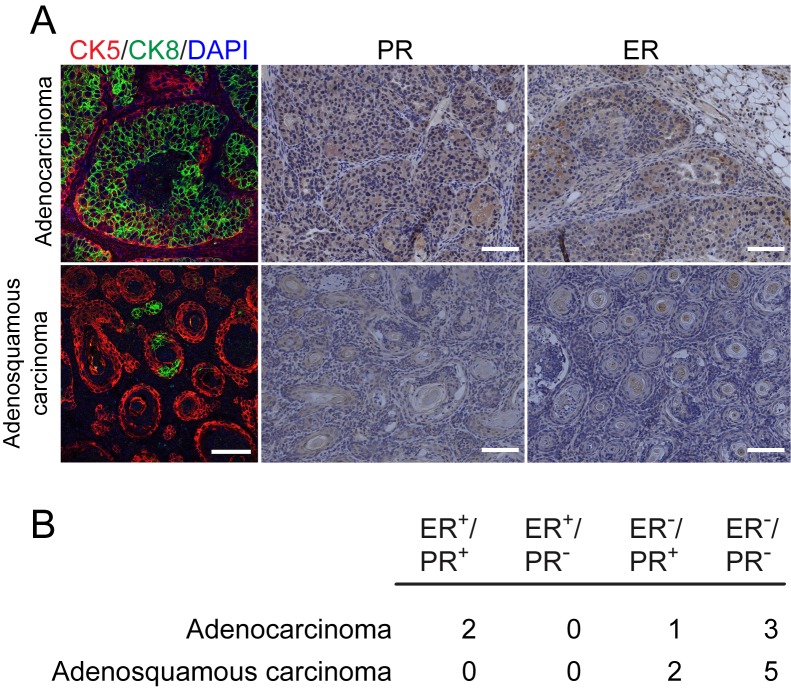
Expression of estrogen and progesterone receptors in breast tumors caused by JNK deficiency in the mammary epithelium.(A, B) Representative adenocarcinoma (upper panel) and adenosquamous carcinoma (lower panel) sections stained for progesterone receptor (PR), estrogen receptor (ER) (Scale bar = 100 µm), and cytokeratin 8 (CK8, green) and cytokeratin 5 (CK5, red) (Scale bar = 50 µm) are presented. Immunofluorescent stains were counterstained with DAPI (left panels), and peroxidase-based staining was counterstained with hematoxylin (center and right panels) (A). Adenocarcinomas and adenosquamous carcinomas were scored for hormone receptor staining (B).